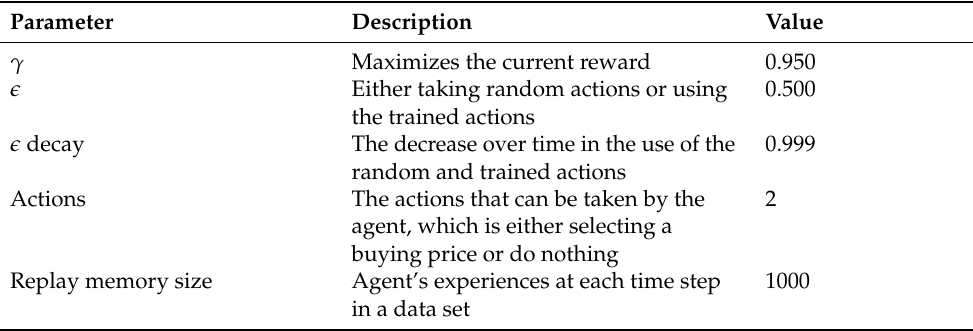
Table 4. Fixed hyperparameters that have been used for the different case combinations in the deep Q-learning